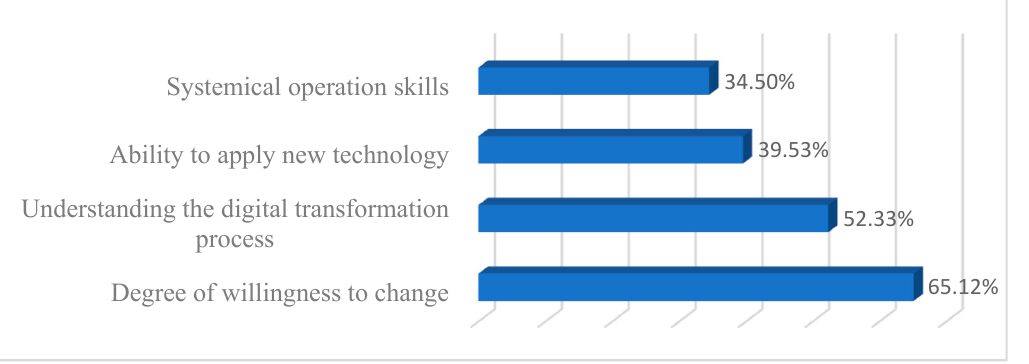
Figure 6. Human resources for digital transformation.